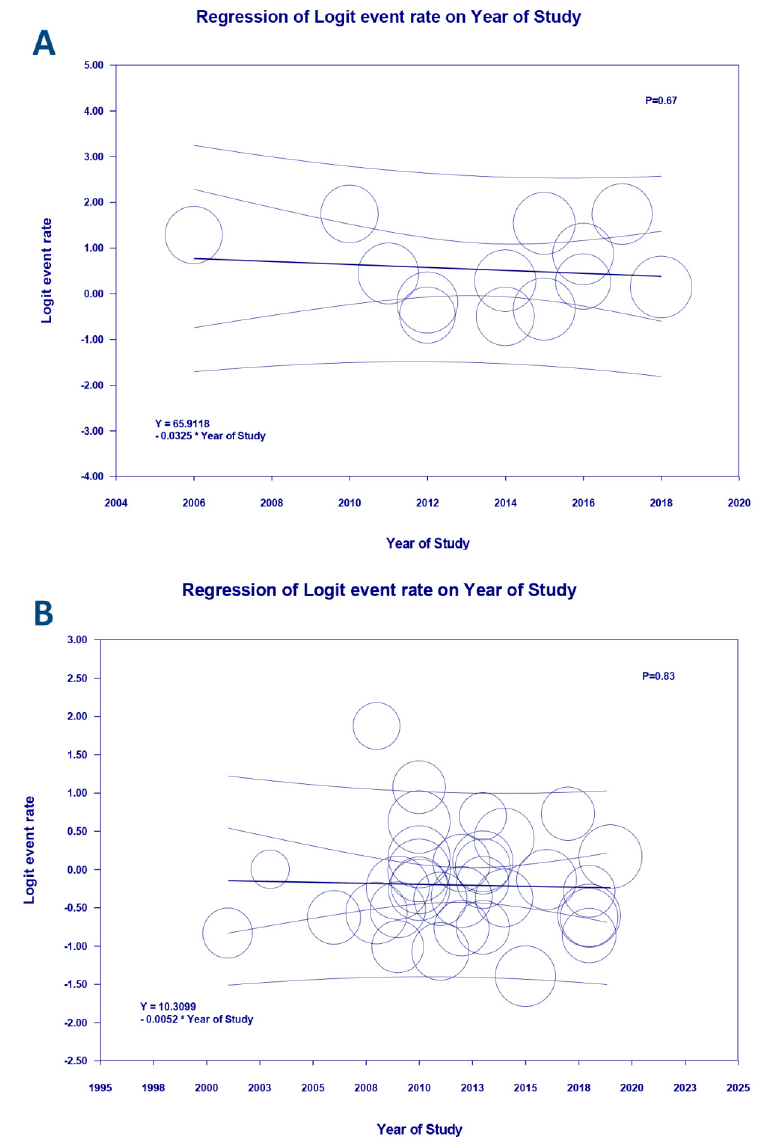
Figure 3. Meta-regression analyses showed that year of the study did not significantly affect ( A ) the incidence of AKI ( p = 0.67) or ( B ) AKI requiring RRT ( p = 0.83). The solid black line depicts the weighted regression line based on variance-weighted least squares. The inner and outer lines represent the 95%CI and prediction interval encompassing the regression line. The circles indicate log event rates in individual study.